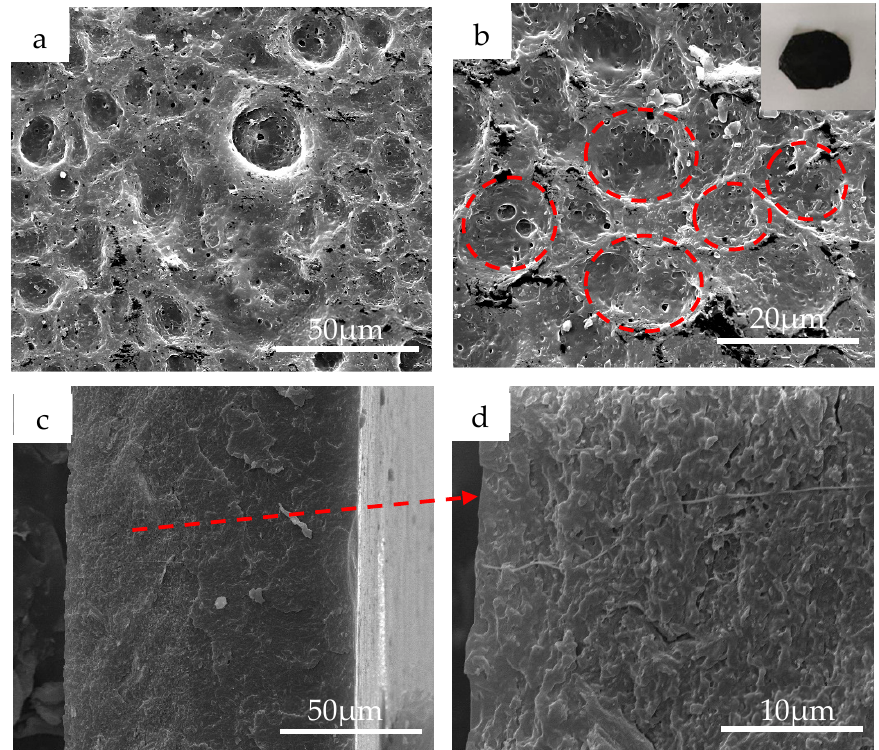
Figure 3. SEM images of CNTs@PANi/SEBS- Ⅱ : ( a ) surface; ( b ) enlarged surface; ( c ) quenched section; ( d ) enlarged view of ( c ).